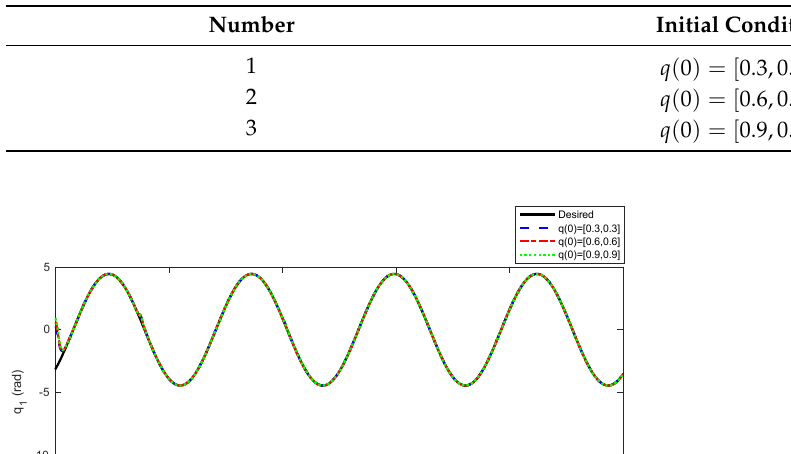
Table 5. Considered initial conditions.